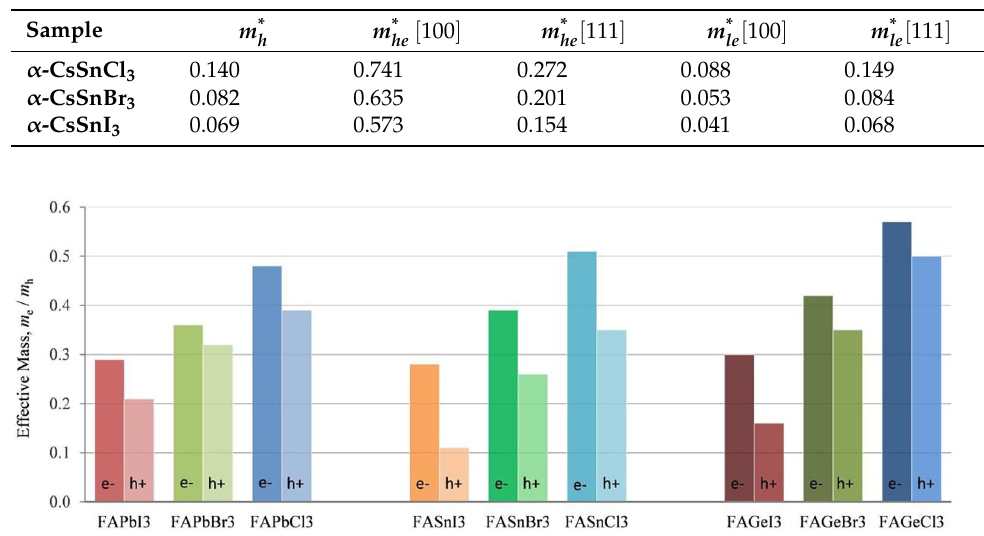
Figure 5. The comparison of the calculated effective mass of FABX 3 perovskite (B = Pb, Sn, Ge; X = I, Br, Cl). Reproduced with permission [32]. Copyright 2019, Elsevier.